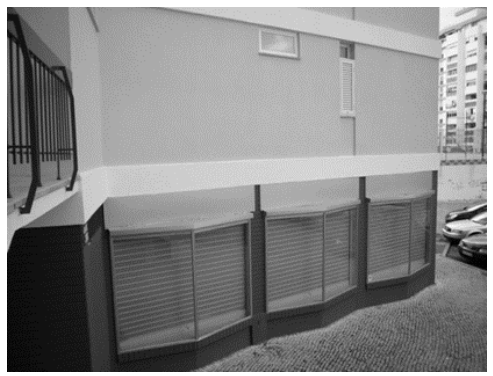
Figure 22. Detail of the windows and basement.